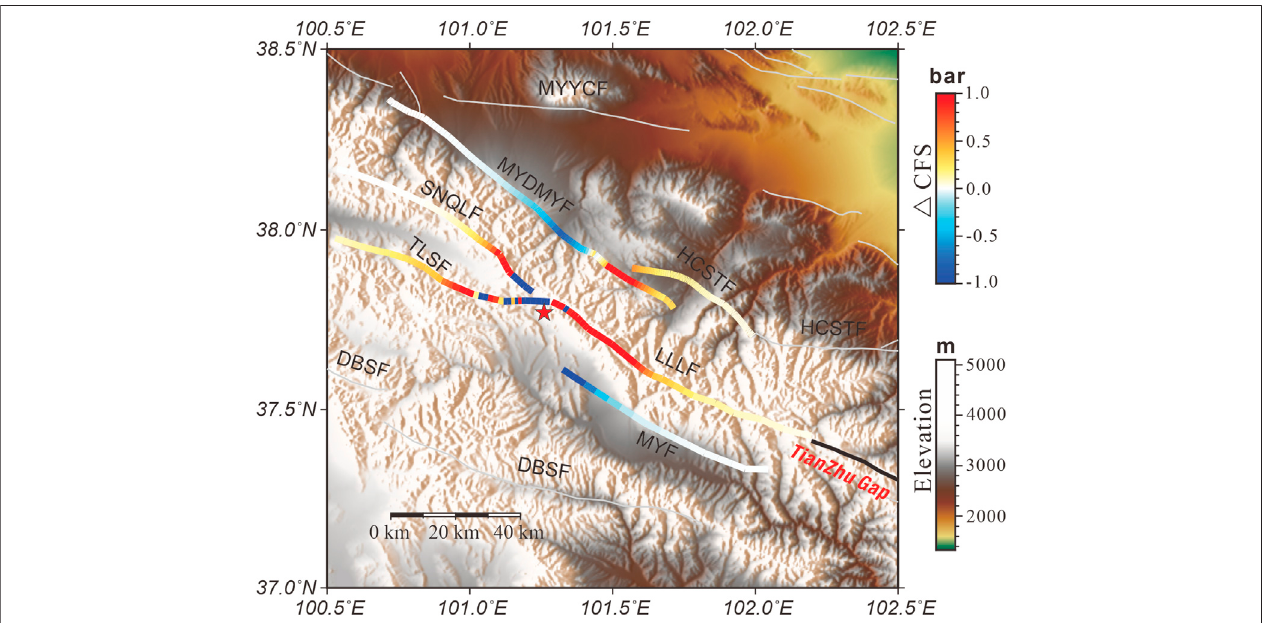
FIGURE13| Static Coulomb stresschangesonthesurroundingfaults at depthof10 km.Thecoloredlines represent thechangesofthestaticCoulomb stresson the surrounding faults caused by the dislocation of the seismogenic fault, and the positive represent the stress loading. Fault parameters are from Xu et al. (2016). The calculation parameters are: Menyuan Fault (reverse fault, dip 45 ° , rake 90 ° ); Lenglongling Fault (left-lateral, dip 90 ° , rake 0 ° ); Tolaishan Fault (left-lateral, dip 90 ° , rake 0 ° ); Sunan-QilianFault(reversefault,dip45 ° ,rake90 ° );Minyue-Damayingfault(reversefault,dip45 ° ,rake90 ° );Huangcheng-ShuangtaFault(reversefault,dip45 ° ,rake 90 ° ). Grey lines indicate the fault traces in this area; black line indicates the “ Tianzhu Gap ” , including the LLLF and the JQHF, MMSF, LHSF to its east. The background image is